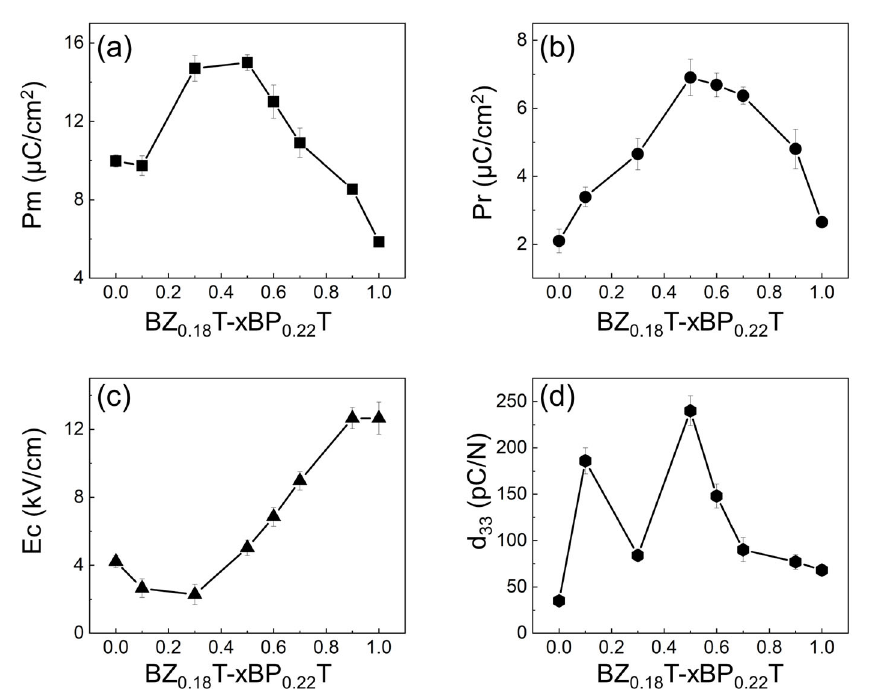
Figure 5. Composition dependence of the maximum polarization Pm ( a ), remnant polarization Pr ( b ), coercive field Ec ( c ), and the piezoelectric coefficient d 33 ( d ) for BZ 0.18 T–xBP 0.22 T . The lines in the figure are guide for the eye.